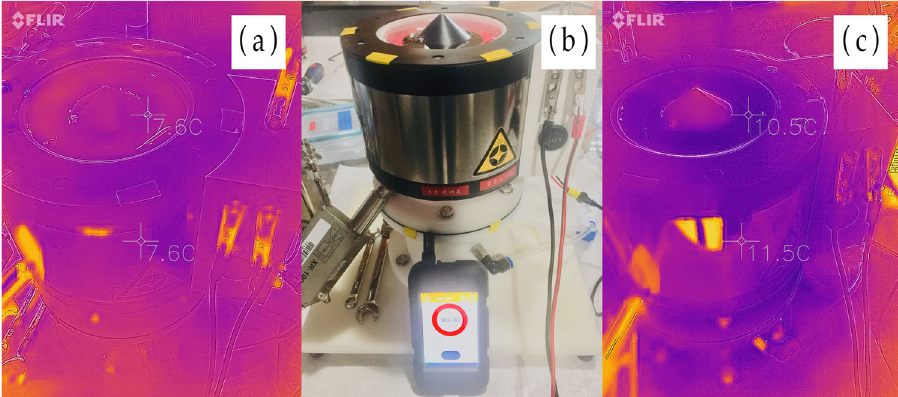
Fig. 5 Temperature and Geiger counter signatures of device before and after energizing. The three images are from one of the FW-AL experiments. a Shows the FLIR temperature signature of device before energizing FW-AL experiment 7/23/2021 at 5:56am. b Shows the Smart Geiger counter next to device detecting 367 uS h − 1 within 60 s of exposure to operational device. c Shows FLIR temperature readings 3 h into experiment. The temperature of dielectric value was 10.5 C while the vessel was 11.5 °C. The fi nal temperature reading after 8 h was 15.3 °C to dielectric and 15.8 °C to vessel. The device and dielectric steady increased in temperature in accordance with the ambient air within the lab.